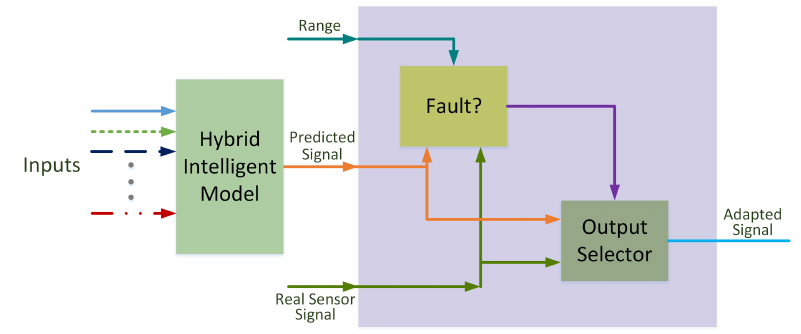
Figure 3. Fault detection and recovery